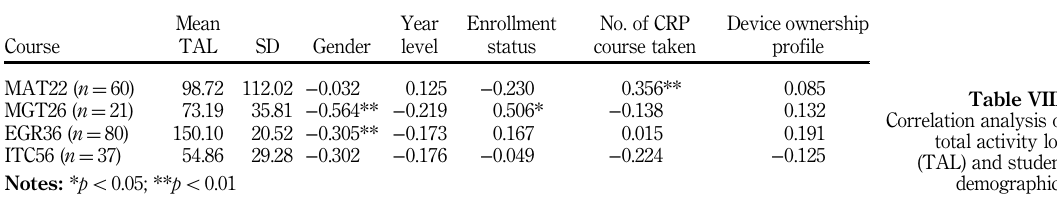
Table VIII. Correlation analysis